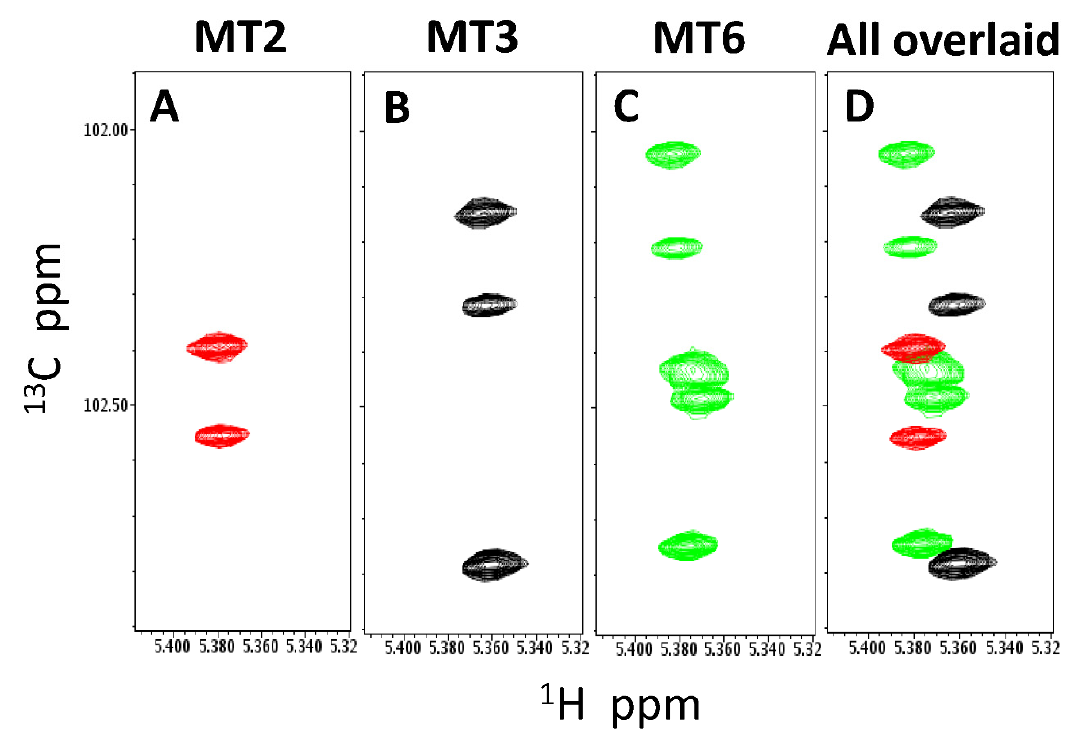
Figure 2. Natural abundance 13 C HSQC spectra are shown for the standard saccharides maltose (MT2) ( A ), maltotriose (MT3) ( B ), and maltohexaose (MT6) ( C ). These 13 C HSQC spectra were focused on acetal/anomeric groups and acquired over a narrow spectral window in the 13 C dimension, effectively reducing the 13 C sweep width producing folded spectra [28]. Because spectra are focused on acetal/anomeric groups, MT2 will show up as 2 peaks, MT3 as 3 peaks, and MT6 as 6 peaks with some overlap primarily for non ‐ terminal glucose residues. Resonance assignments for MT2, MT3, and MT6 were reported by Goffin et al. (2009) and confirmed here by running and analyzing 1 H ‐ 13 C HSQC and 1 H ‐ 13 C HMBC experiments. ( D ) 13 C HSQC spectra from panels ( A – C ) are superimposed in ( D ). Peaks are colored as red for MT2, black for MT3, and green for MT6. Solution conditions are 20 mM potassium phosphate, pH 7, 30 °C.